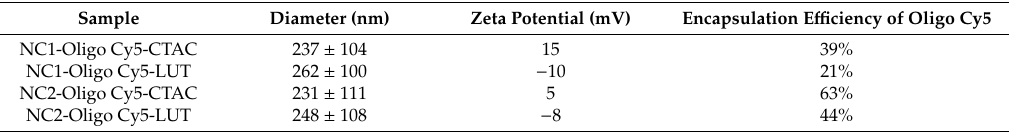
Table 1. Overview of silica nanocapsules encapsulated Oligo